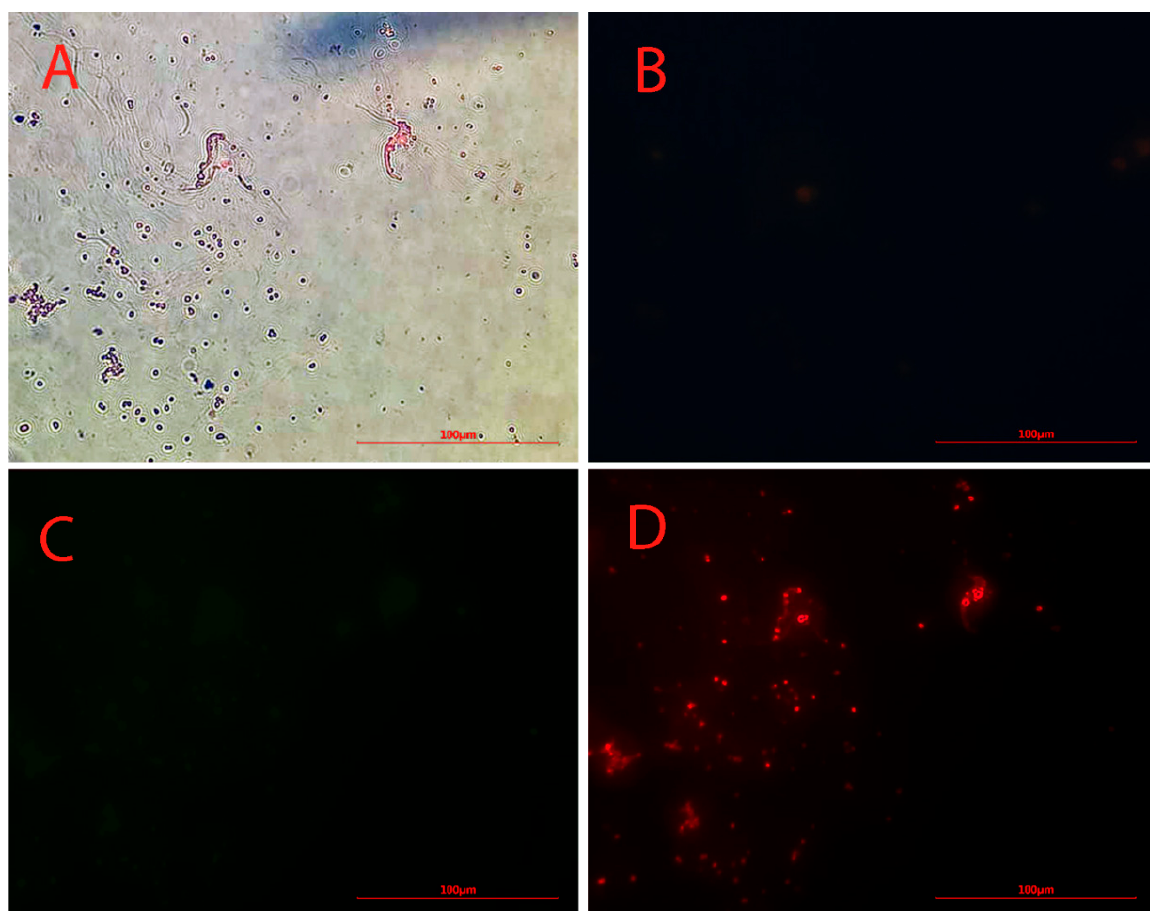
Figure 2. Microscopy images of Alexa Flour 594 anti-Oct4 antibody-conjugated nanoparticles using ( A ) brightfield, ( B ) blue filter, ( C ) green filter, and ( D ) red filter.